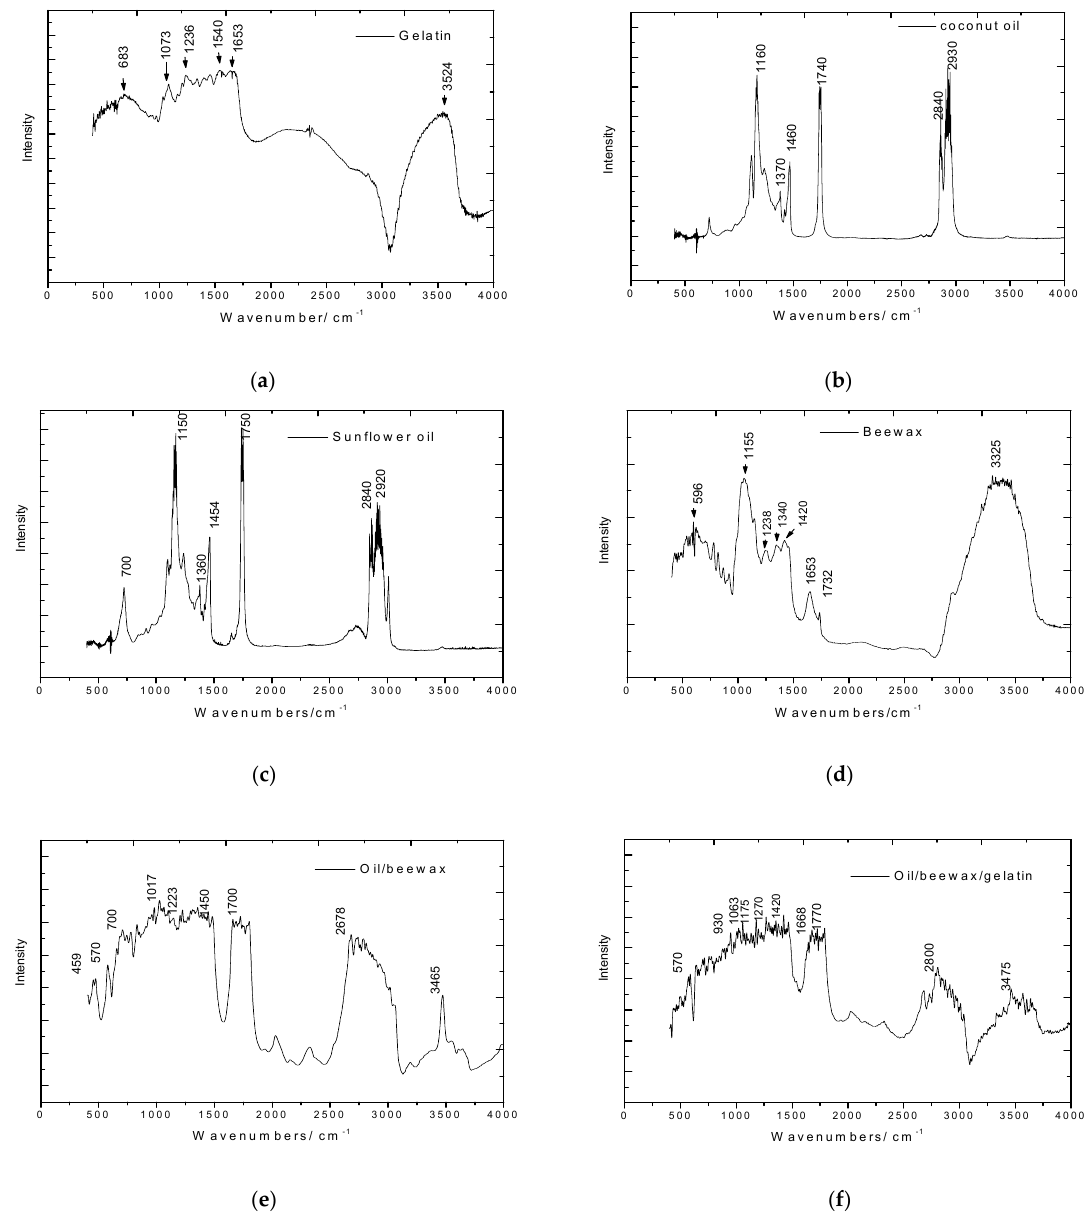
Figure 2. FTIR spectra of the edible coating components and their combinations. Spectra of ( a ) gel ‐ atine, ( b ) coconut oil, ( c ) sunflower oil, ( d ) beeswax, ( e ) combination of coconut and sunflower oil with beeswax (O+W), ( f ) combination of coconut oil, sunflower oil, beeswax and gelatine (O+W_G).